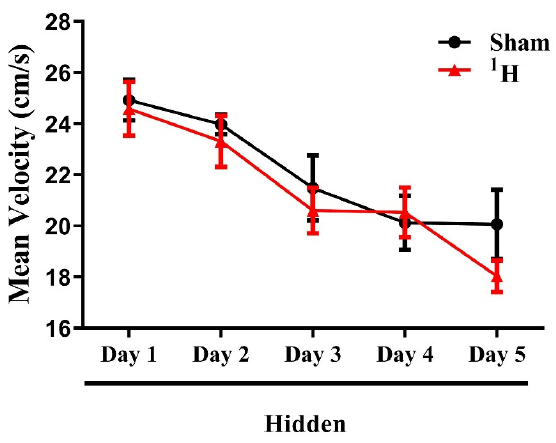
Figure 3. Morris water maze swim velocity. There was no significant treatment-by-day interaction for velocity. Hidden indicates the platform was not visible during the training trials.